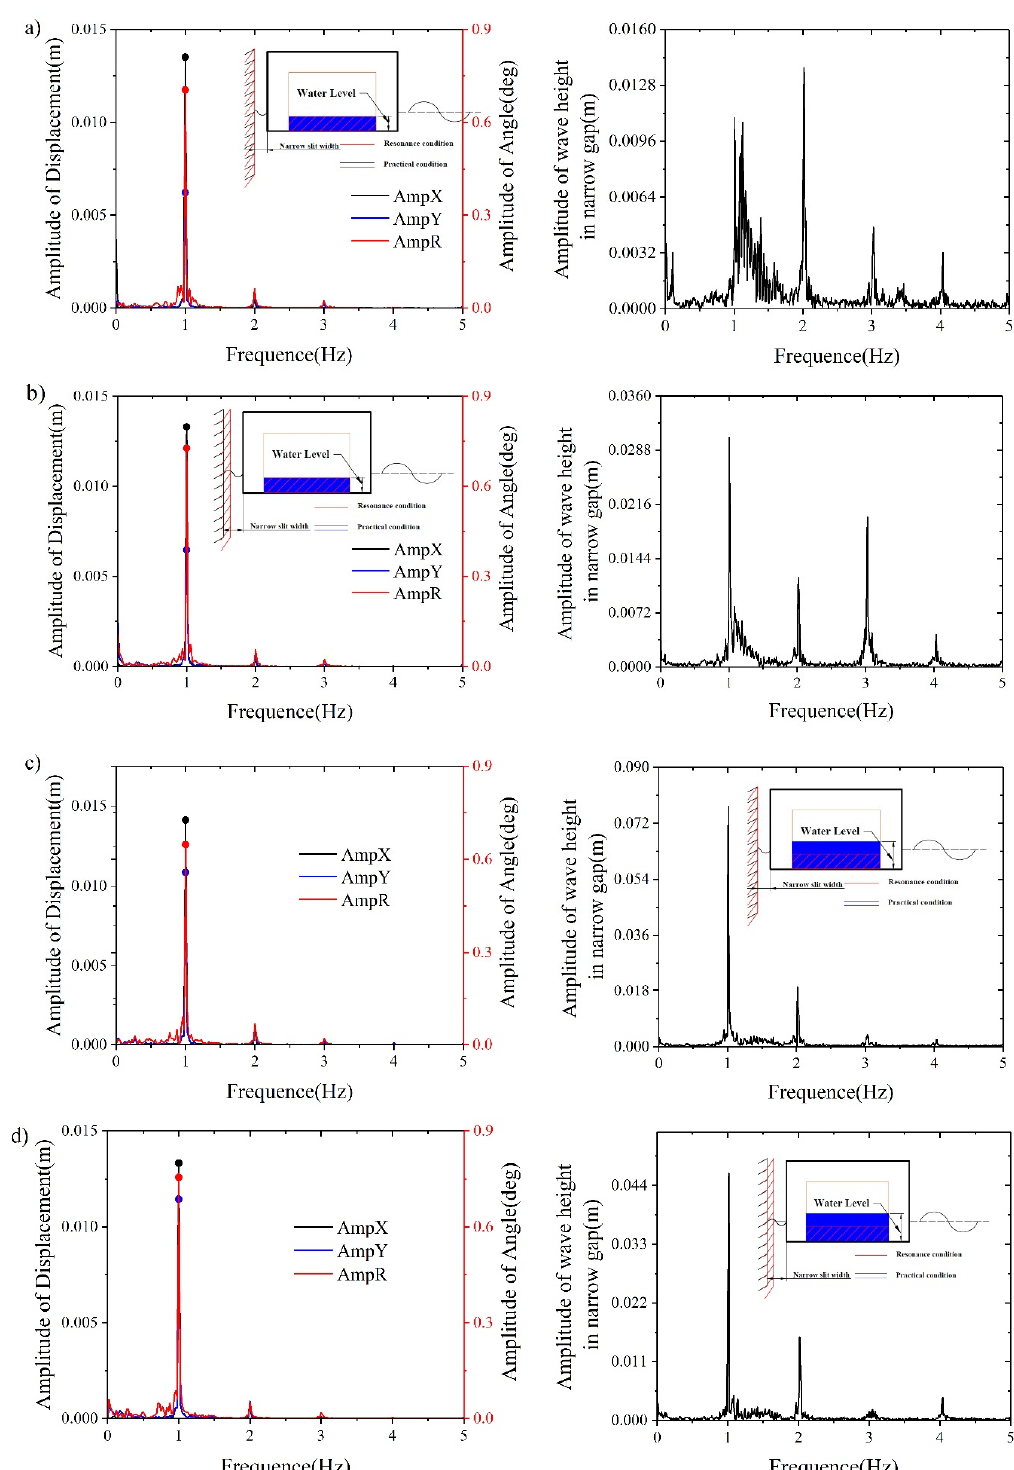
Figure 5. Motion response of a berthed floating tank. ( a ) The double resonance of sloshing and the narrow gap in Case 2-5(+); ( b ) the sloshing resonance in working Case 2-6(|); ( c ) narrow gap resonance in Case 2-1(-); ( d ) the absence of resonance in Case 2-2(o).